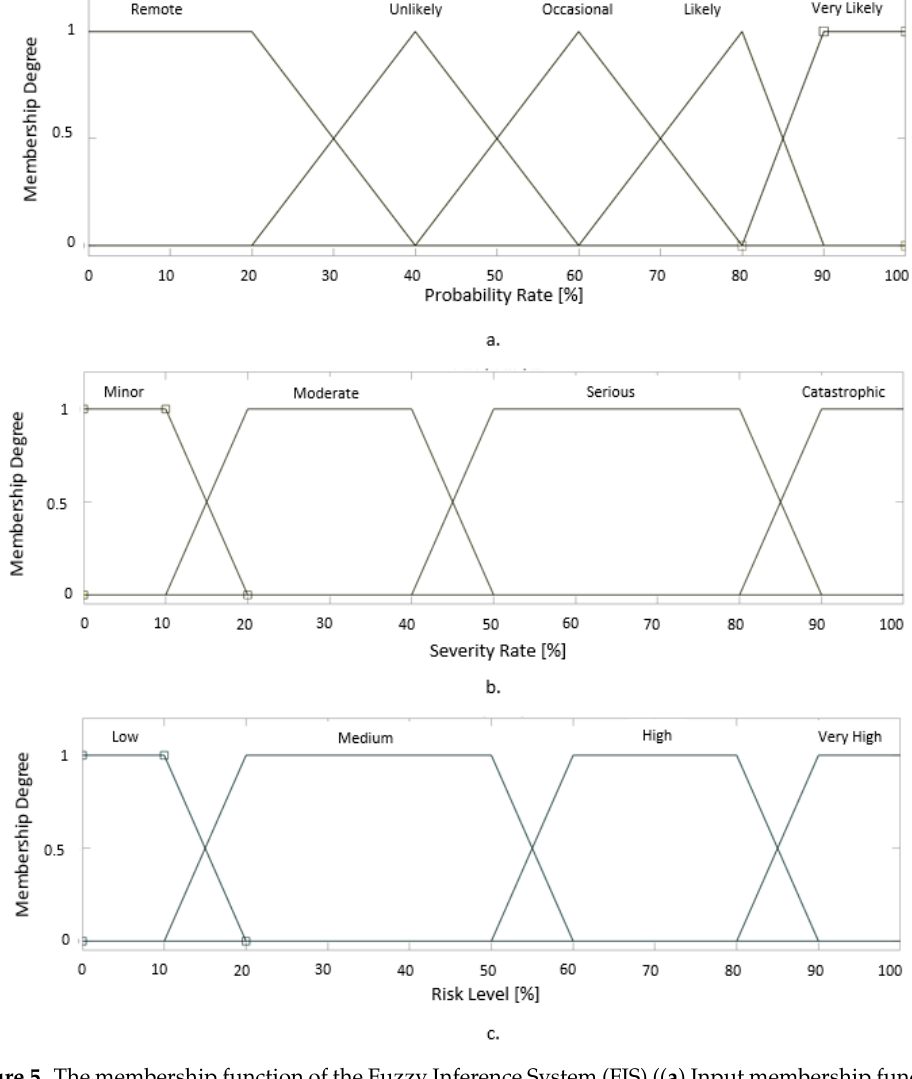
Figure 5. The membership function of the Fuzzy Inference System (FIS) (( a ) Input membership function for Probability of the hazard, ( b ) Input membership function for the severity of the hazard, ( c ) Output membership function for the Risk Level of the hazard).